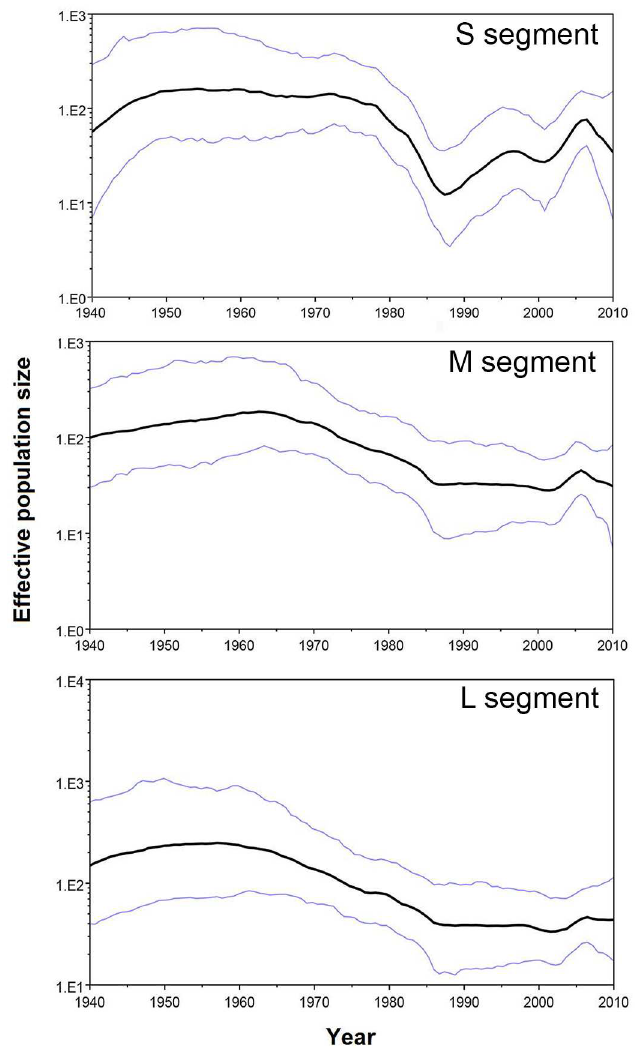
Fig 2. Gaussian Markov Random Field (GMRF) Bayesianskyride plots for all three RVFV segments, representing the relationship between reconstructed effectivepopulation size and calendar year. Blue lines show the boundariesof the 95% highest posterior density